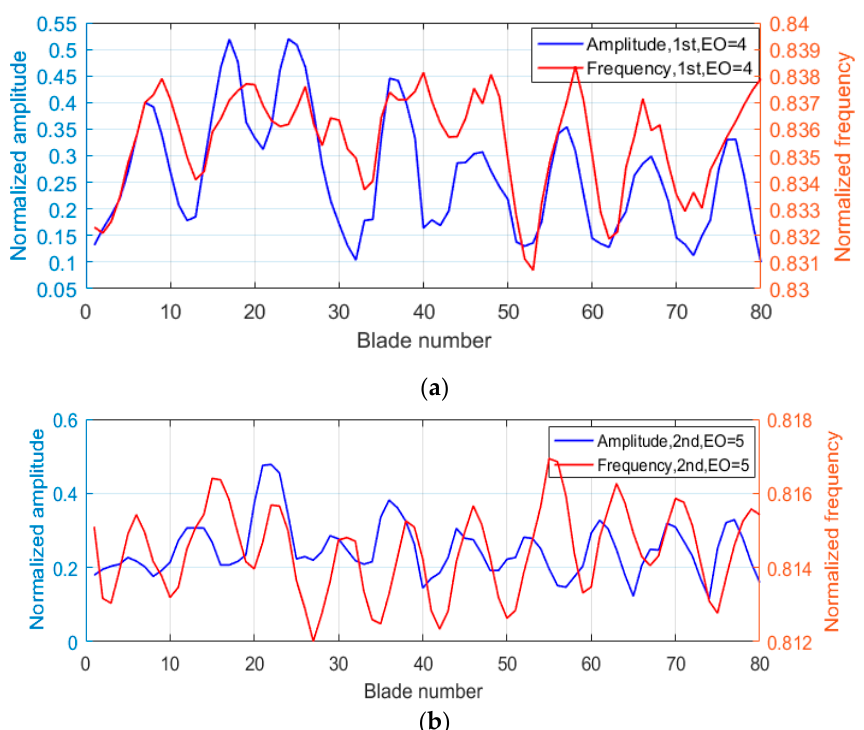
Figure 15. Comparison of normalized frequencies with amplitudes: ( a ) first, EO = 4 and ( b ) second, EO = 5.